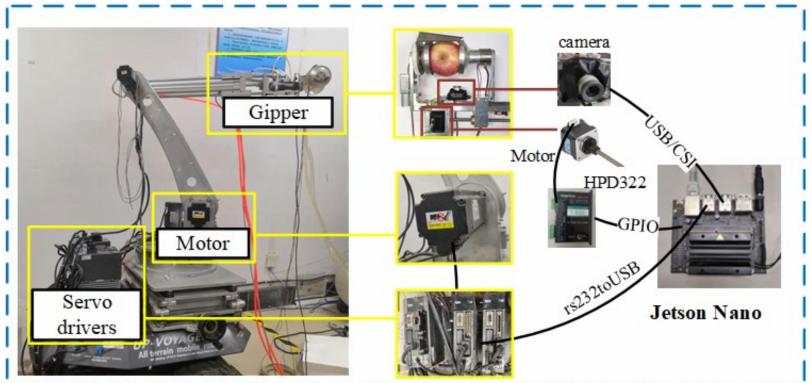
Figure 11. The apple picking experimental